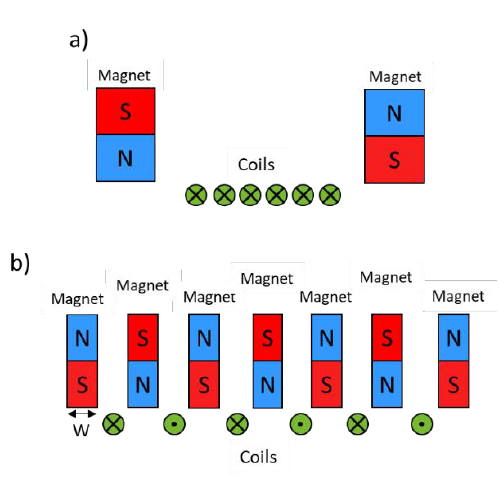
Figure 3. Diagram of two possible designs of the EMAT probe.